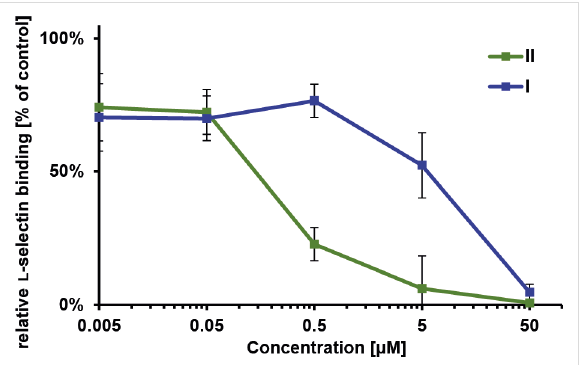
Figure 3: Concentration-dependent relative L-selectin binding of the supramolecular polymers I and II in HEPES buffer (0.020 M, pH 7.4, with 0.150 M NaCl and 0.001 M CaCl 2 ) measured by SPR. L-Selectin- coated nanoparticles were preincubated with solutions of the supramo- lecular polymers. Their affinity towards multimerized artificial ligands composed of sulfated tyrosine and sialyl-Lewis X , immobilized on